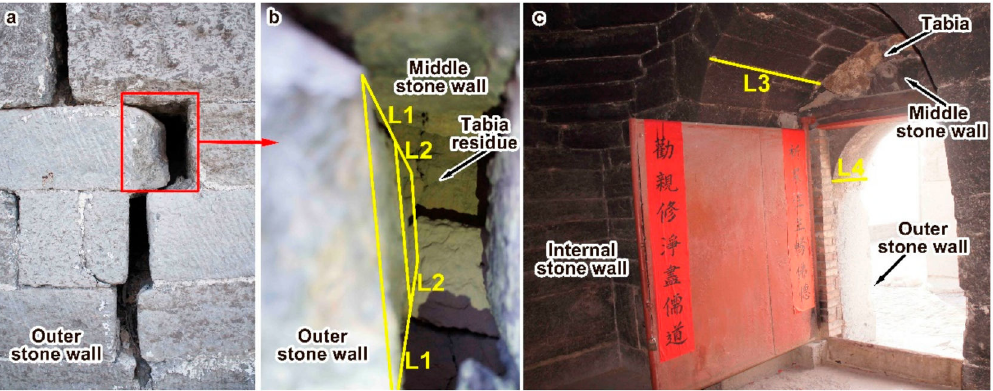
Figure 10. Structural layer analysis of limestone hall and dimension measurement of all layers. ( a ) Out-wall crack in the north of limestone hall; ( b ) Architectural structure seen from crack of north wall; ( c ) Architectural structure seen from south of inside limestone